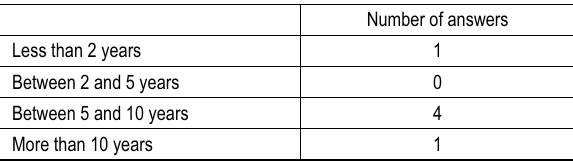
Table 8. Answer to the question: age of the currently